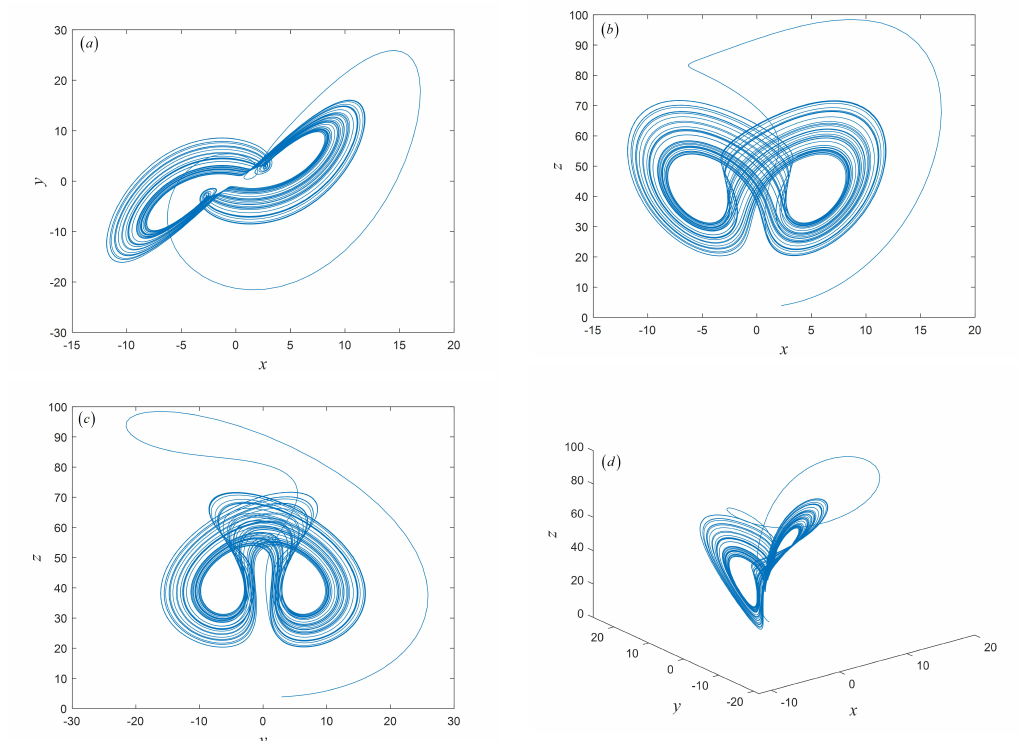
Figure 1. Phase–space trajectory distribution of fractional delay financial system: ( a ) X–Y plane; ( b ) X–Z plane; ( c ) Y–Z plane; ( d ) X–Y–Z